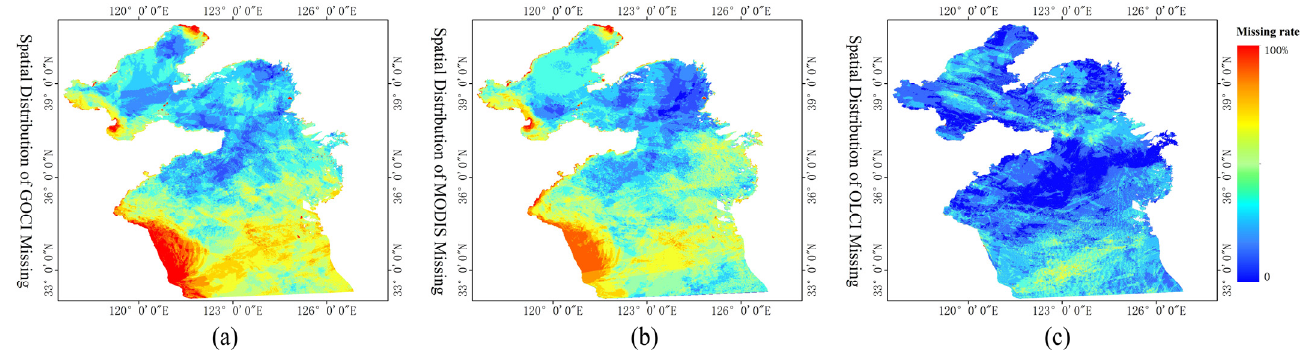
Figure 12. Schematic of the spatiotemporal image of the data-free area: ( a ) GOCI, ( b ) MODIS and ( c ) OLCI. ( c )